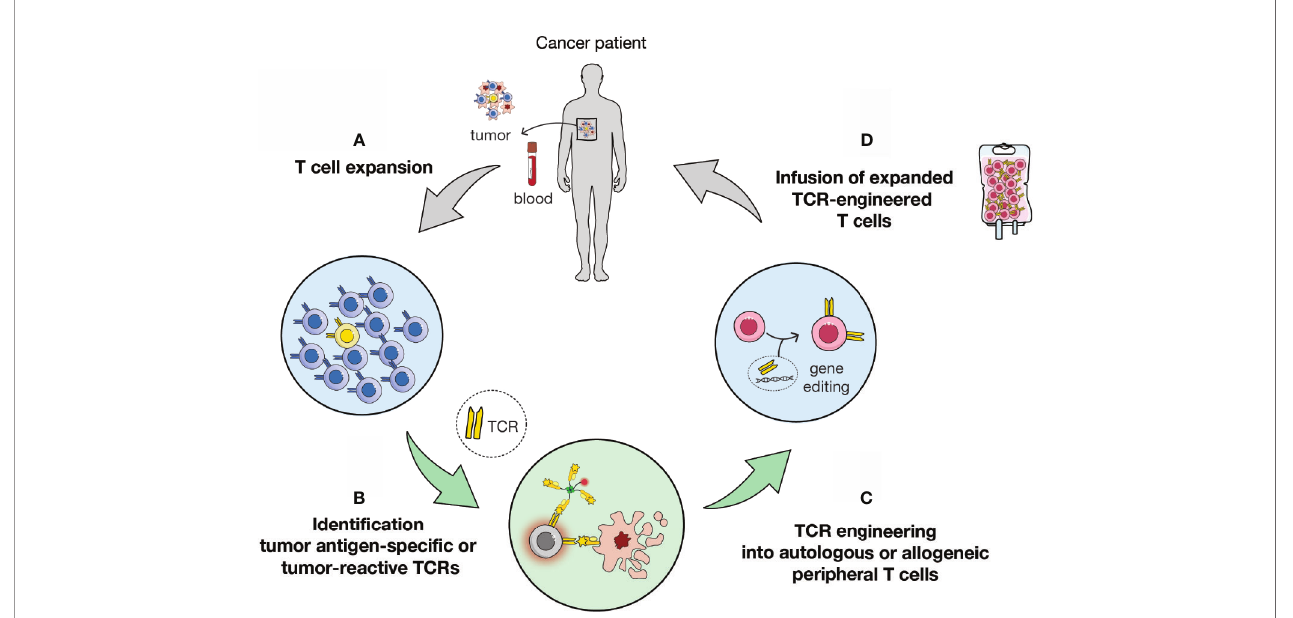
FIGURE 1 | Overview of TCR-based immunotherapy. (A) Expansion of T cells from tumor or blood samples of patient or healthy donors. (B) Identi fi cation of antigen- speci fi c or tumor-reactive T cells and of cognate T cell receptors (TCRs). (C) Transduction of autologous or allogenic carrier cells. (D) Adoptive cell transfer of TCR- engineered cells to the